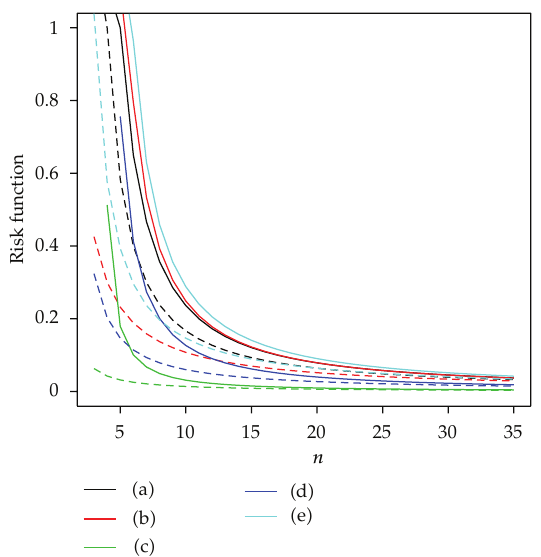
Figure 4: Risk function of estimators under the extended Je ff reys’ prior for di ff erent n with c 1 (cid:5) 2.